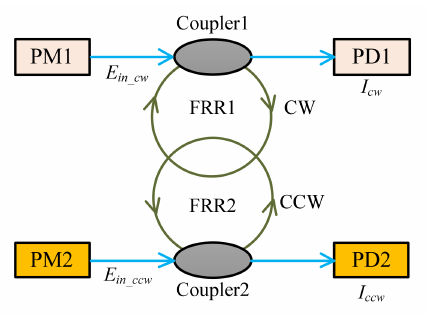
Figure 4. CW and CCW waves in the parallel-double HCPCF ring